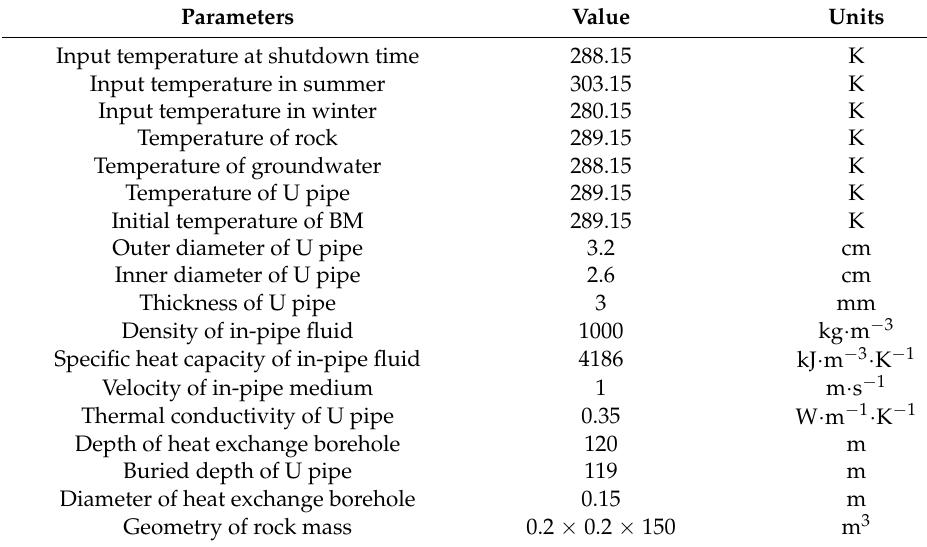
Table 4. Parameters of the underground heat exchanger.